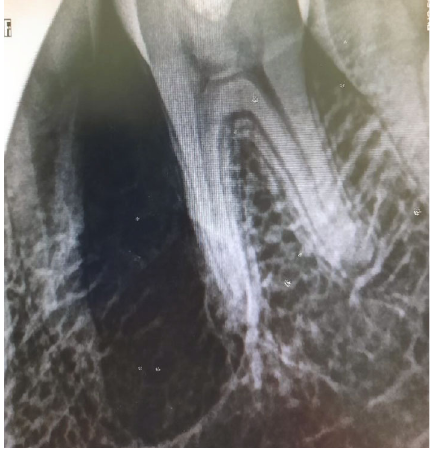
Figure 3: Radiovisiography taken the day of the consultation